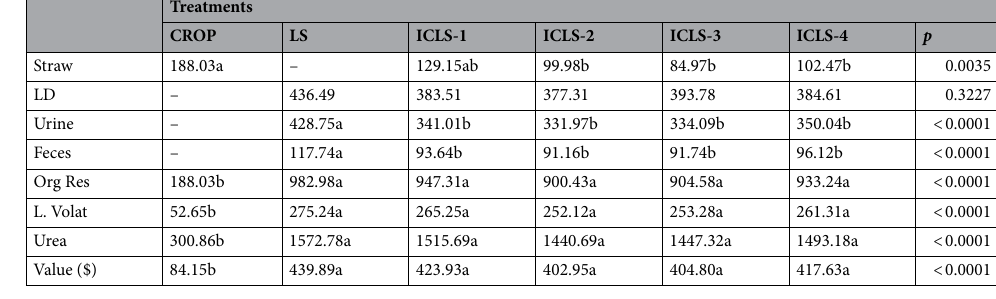
Table 3. Amount of nitrogen (kg ha −1 ) and valuation of organic residues. Means followed by distinct letters are statistically different, according to the Tukey’s test at a 5% probability level. Average tonne of urea (2010– 2020); kg urea = $0.28 (Source: World Bank Price Data). Value: estimated value of organic residues. CROP production of maize grain, LS production of beef cattle in pasture, ICLS-1 maize and Marandu grass sowed simultaneously without herbicide, ICLS-2 maize and Marandu grass sowed simultaneously with herbicide, ICLS-3 delayed sowing of maize and Marandu grass, ICLS-4 maize and Marandu grass sowed simultaneously in maize lines and interlines with herbicide, LD litter deposited, Org Res organic residue, amount of nitrogen in straw, litter deposited, urine and feces, L. volat losses of nitrogen by volatilization, urea equivalent to the urea fertilizer, with 45% of